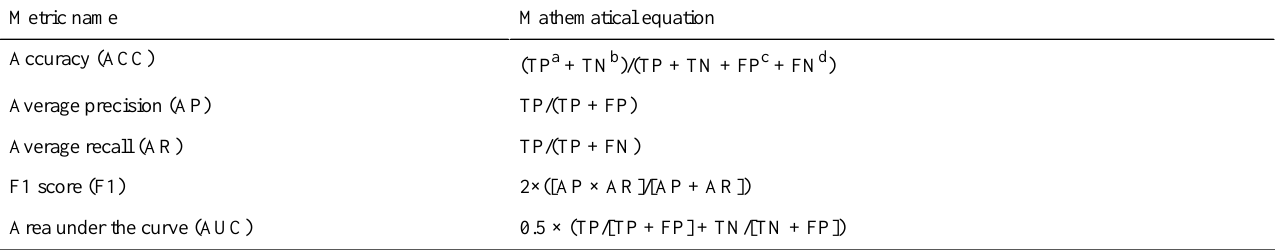
Table 2. Mathematical definition of our selected performance evaluation